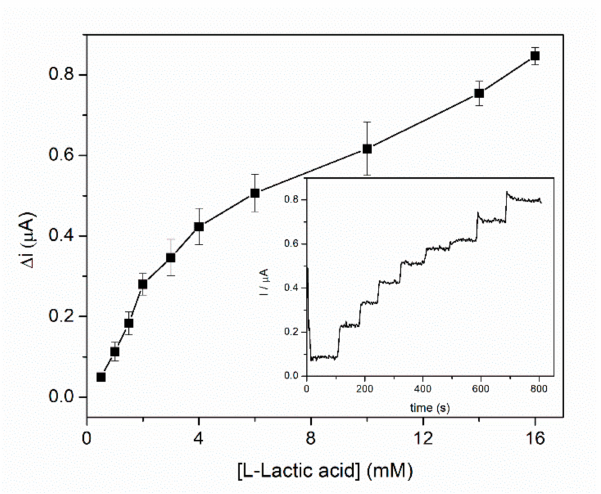
Figure 6. Calibration graph of GA-LDH/AuNPs-ERGO-PAH/SPE biosensor (E = +500 mV, [NAD + ] = 8 mM, PBS 0.1 M pH = 7.5, n = 3) (inset: biosensor response to successive L-lactic acid additions).